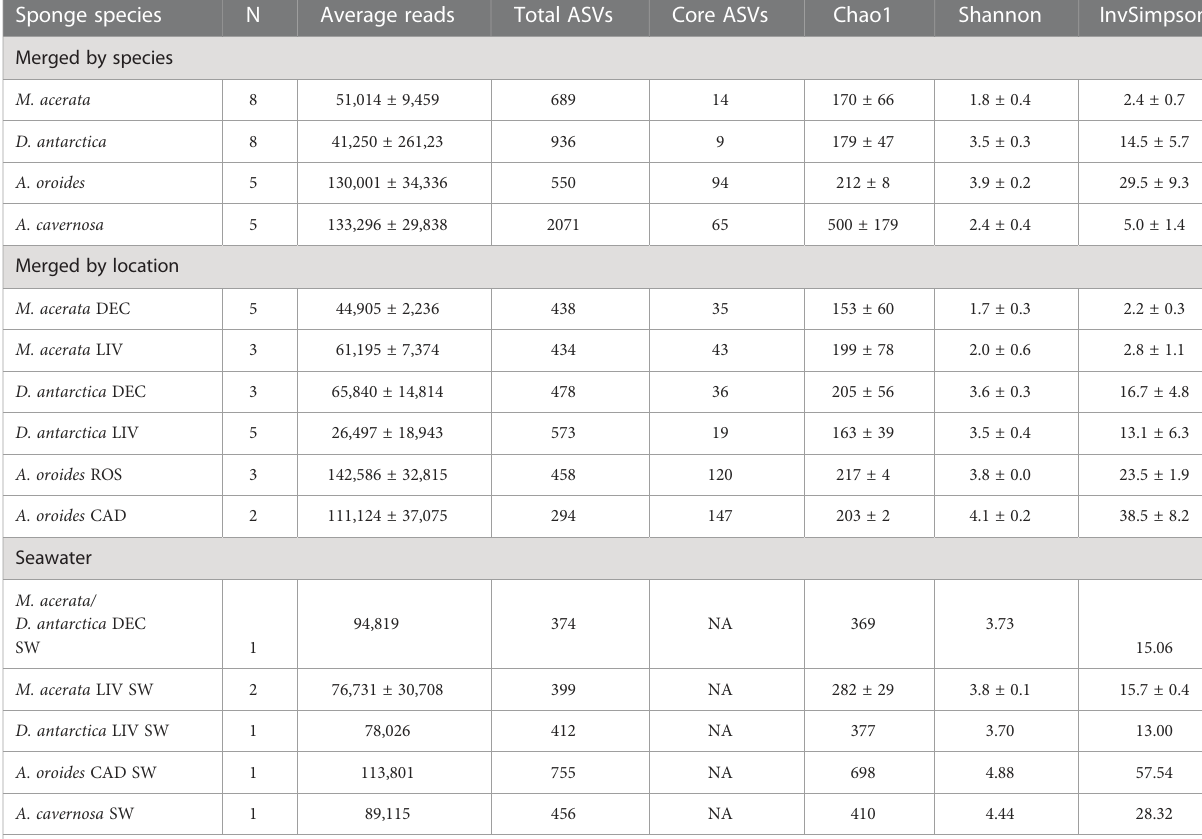
TABLE 2 Summary of reads, ASVs, and diversity of sponge species and water of the different geographic areas. Sponge species N Average reads Total ASVs Core ASVs Chao1 Shannon InvSimpson Merged by